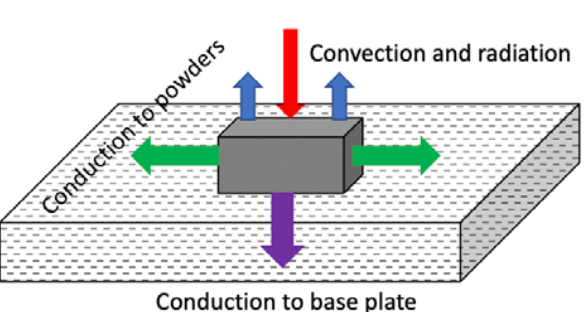
Figure 1. Heat transfer mechanisms in laser powder bed fusion.